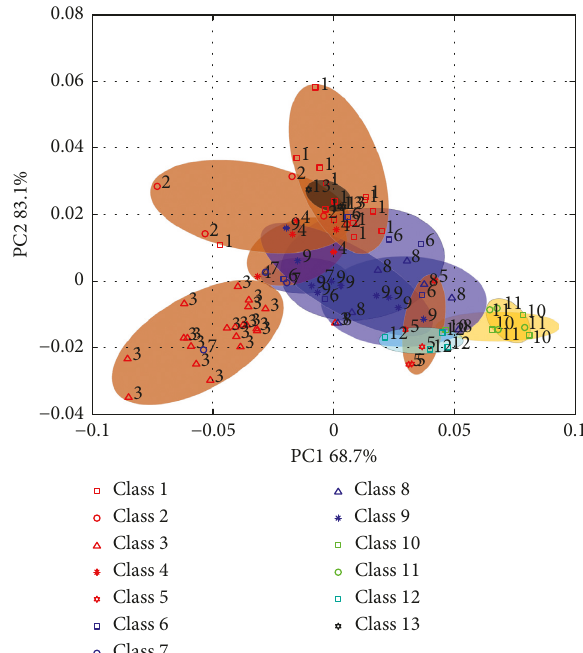
Figure 2: Score plots of the first principal component versus the second obtained from principal component analysis. PC1: the first principal component and PC2: the second principal